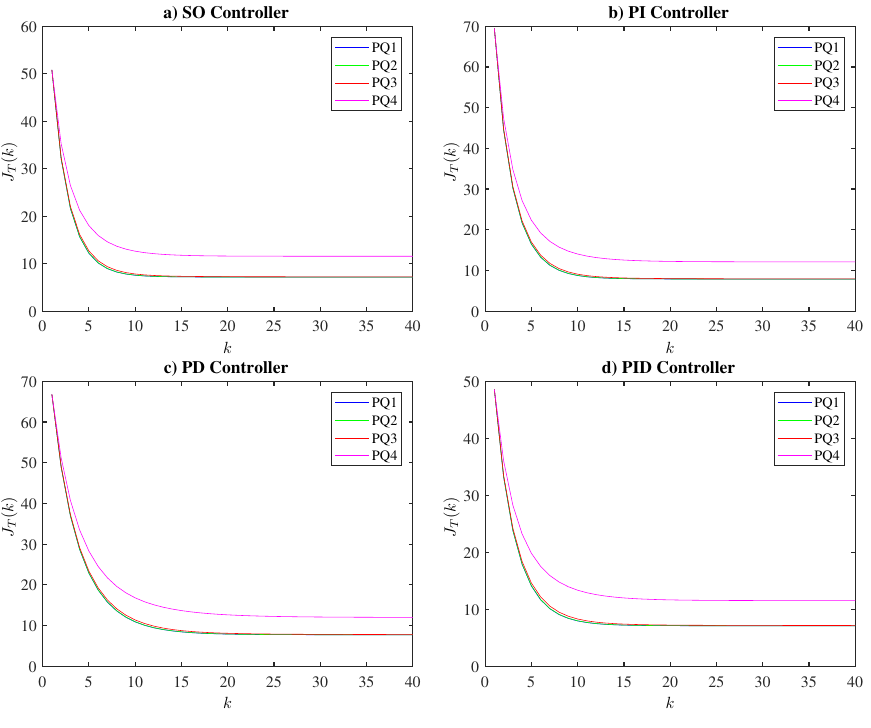
Figure 9. Optimization process results for the objective function J T ( k ) .